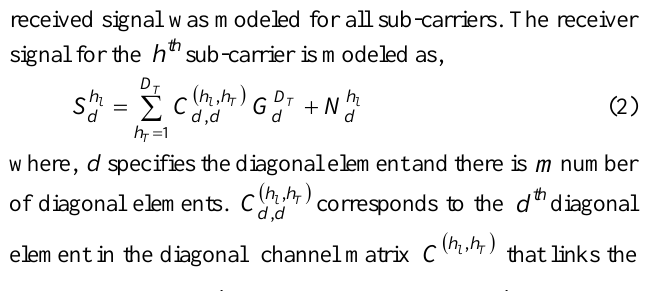
Fig. 1.Depicts the MIMO-OFDM block